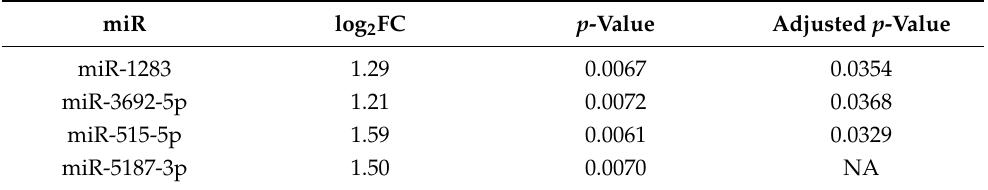
Table 3. Plasma cfmiRs down-regulated in post-operative plasma samples that were also differentially expressed between pre-operative and NHDs plasma